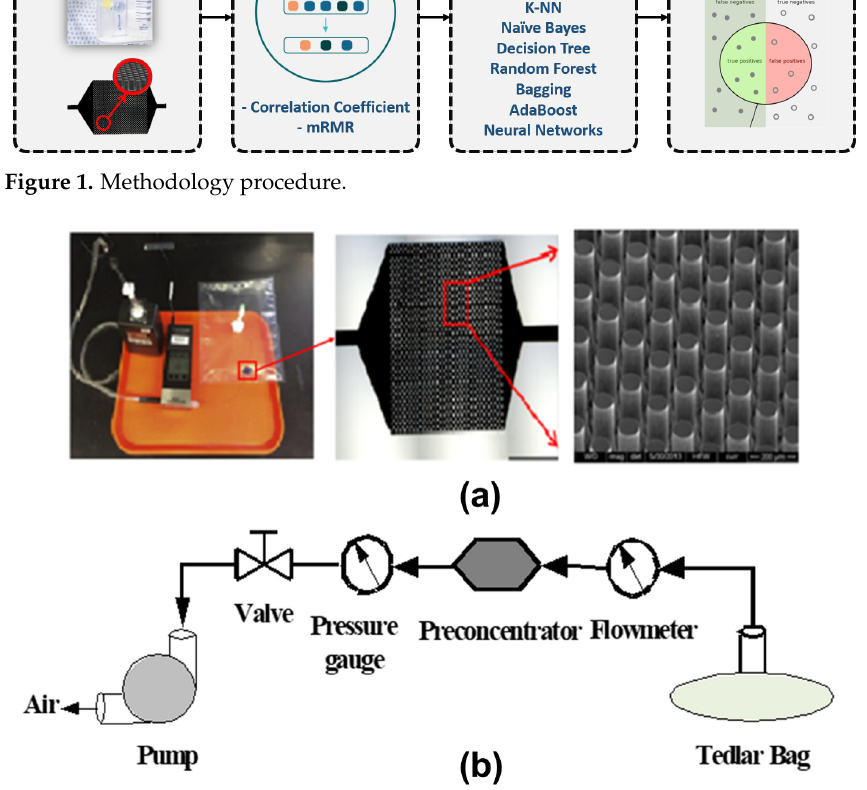
Figure 2. ( a ) A snapshot of the breath collecting system; points to a DRIE-created optical image of the microfabricated microchip with fused silica tubes attached to the intake and exit ports; points to a SEM micrograph of the micropillar array within the preconcentrator; ( b ) setup diagram for capturing carbonyl VOCs from exhaled